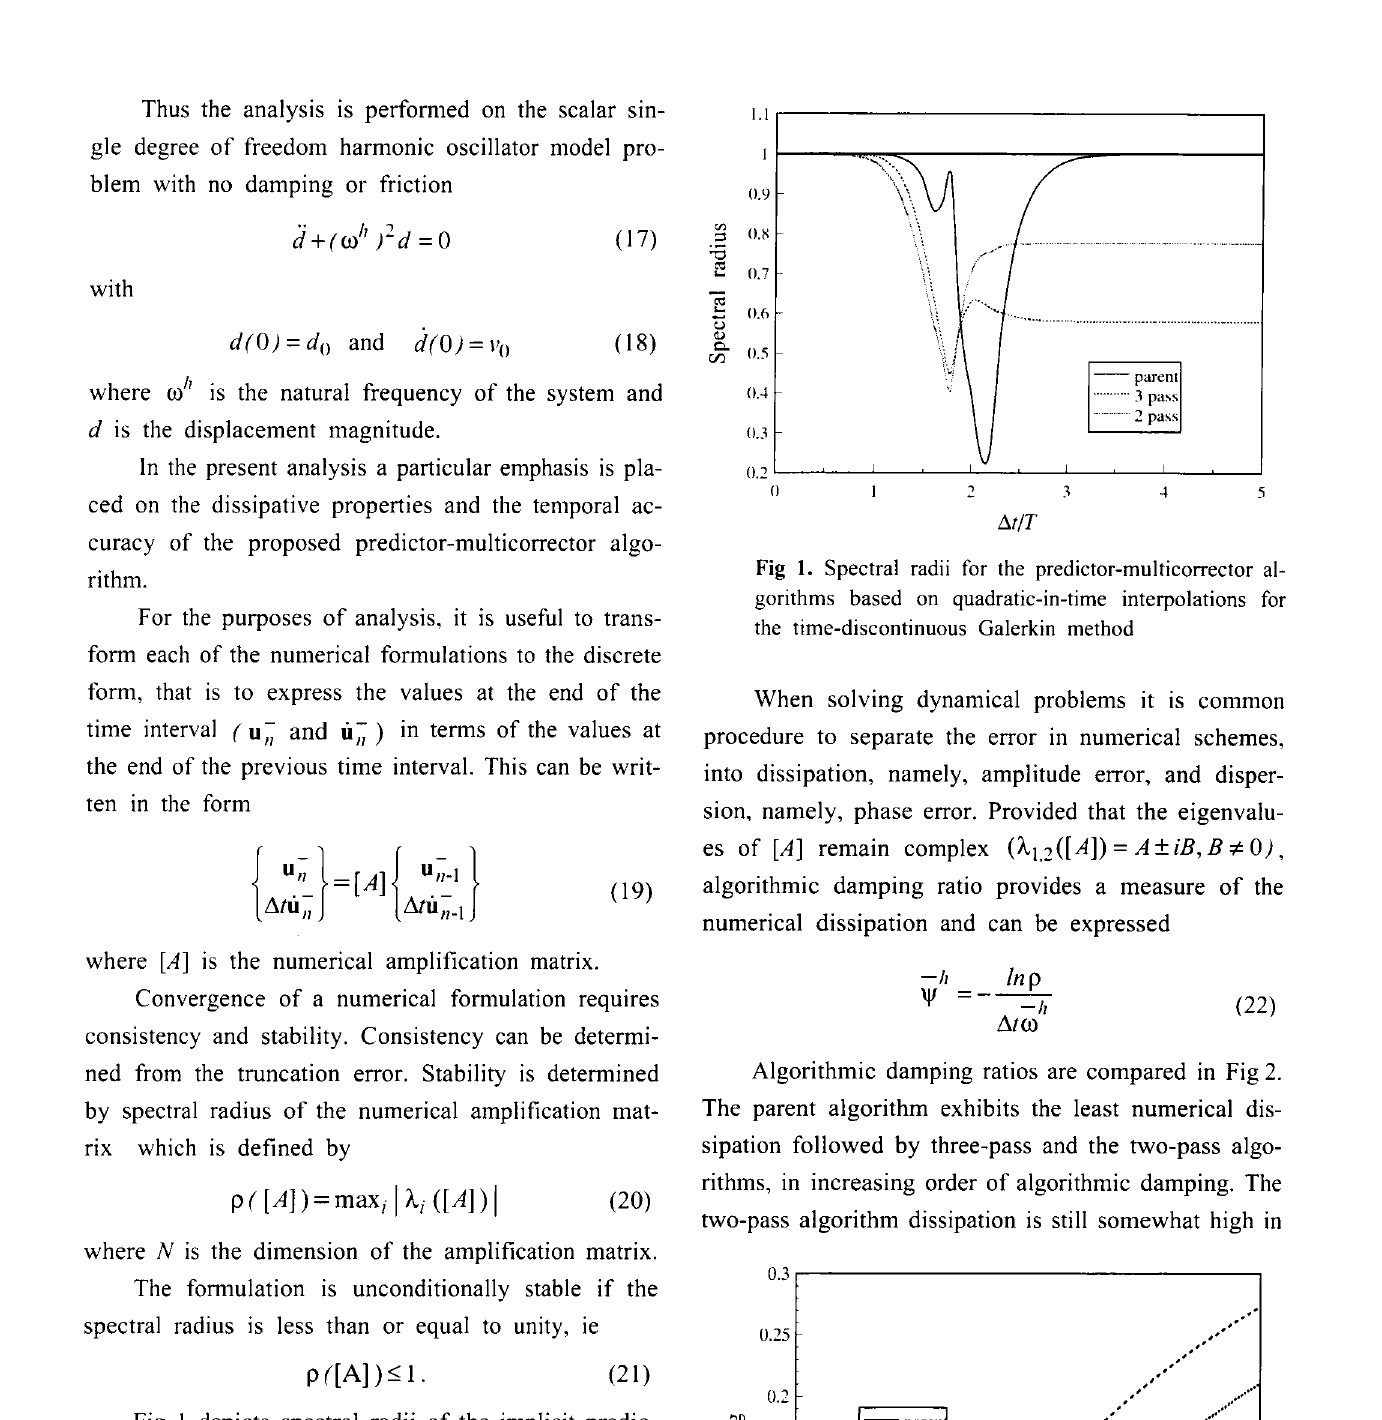
Algorithmic damping ratios are compared in Fig 2.